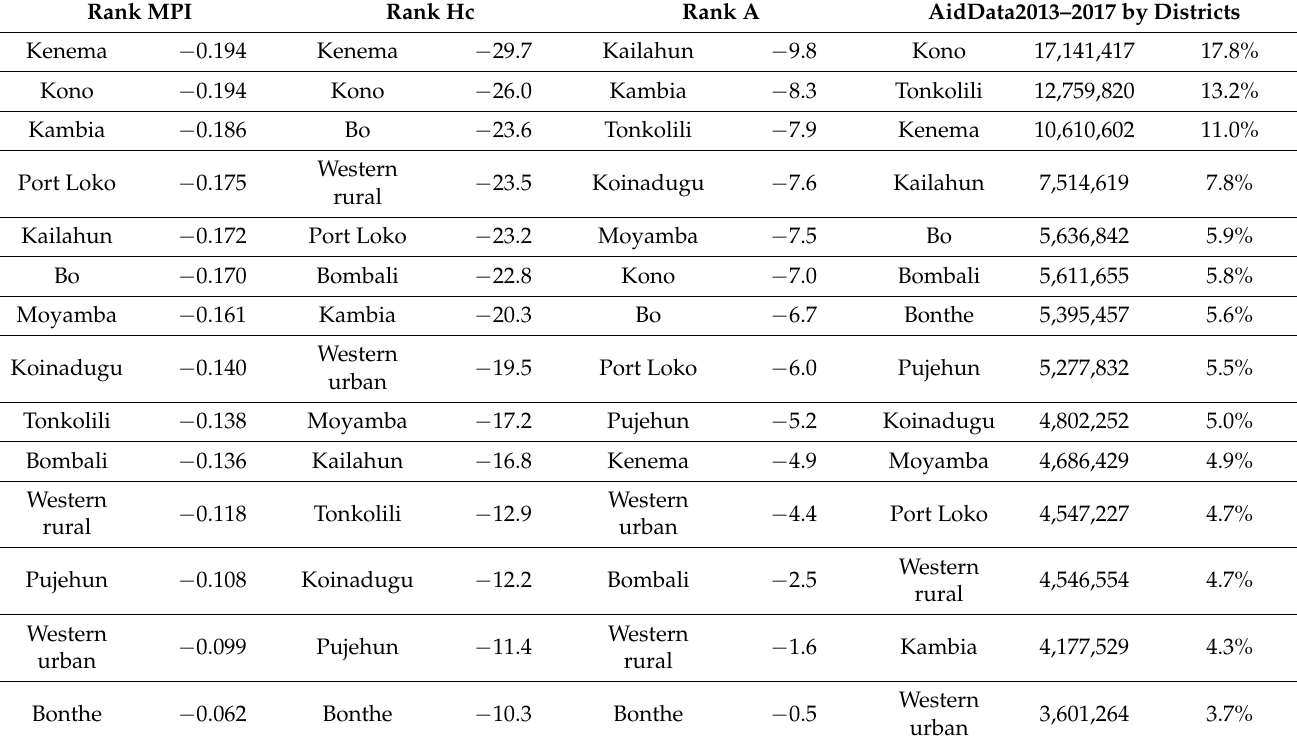
Table 9. Poverty and foreign aid by